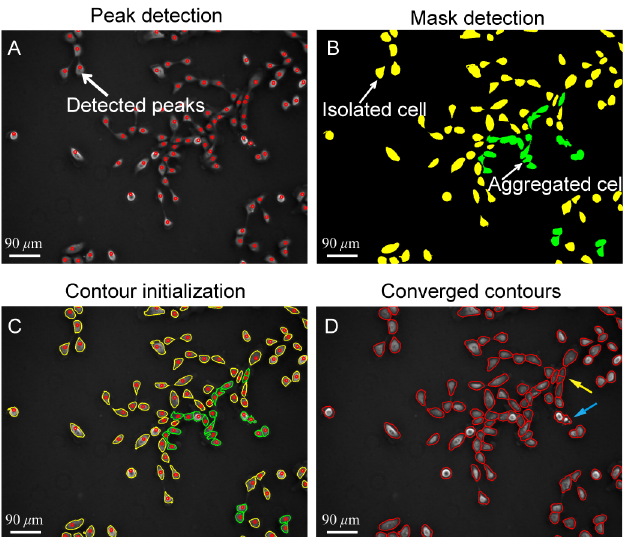
Fig 11. Demonstration of cell localization, boundary detection, and segmentation of the clustered cells. (A) For the negative phase contrast image, peaks of light intensity are detected for all cells, as indicated by red circles. (B) Preliminary masks are obtained with the thresholding method. Masks in green are areas with multiple peaks indicating clustered cells. Masks in yellow are areas with single cell. (C) The boundaries of the preliminarily detected masks are extracted to serve as initial contours for individual cells. (D) Contour expansion method is applied to detect cell boundaries for all cells in the-field-of-view. Except one oversegmentation (marked by a yellow arrow) and one falsely detected cell from a debris (marked by a blue arrow), all the other cells are successfully segmented.